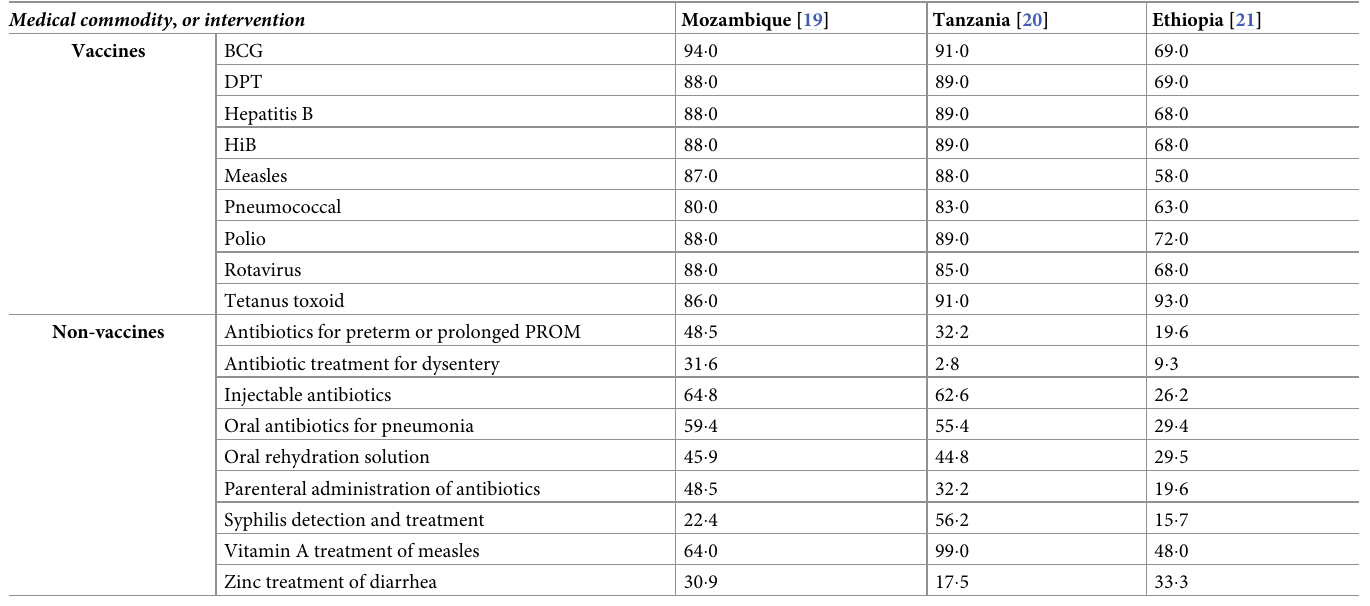
Table 2. Country-specific baseline coverage (%) in Lives Saved Tool (LiST) software.